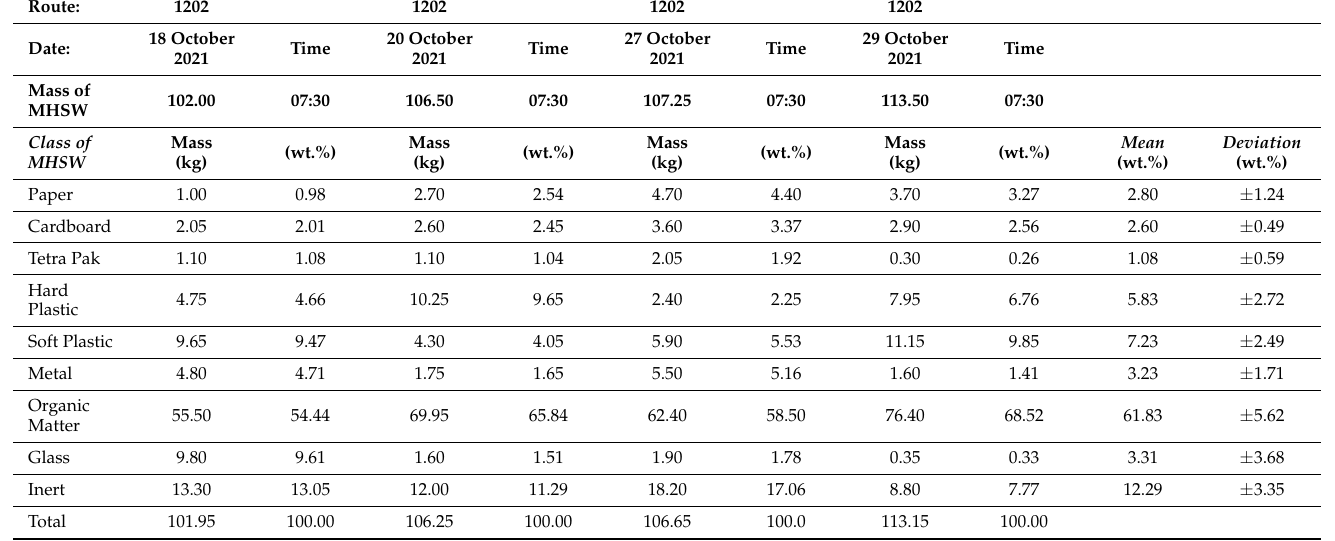
Table 5. Gravimetric analysis of Municipal Household Solid Waste (MHSW) in the city of Bel é